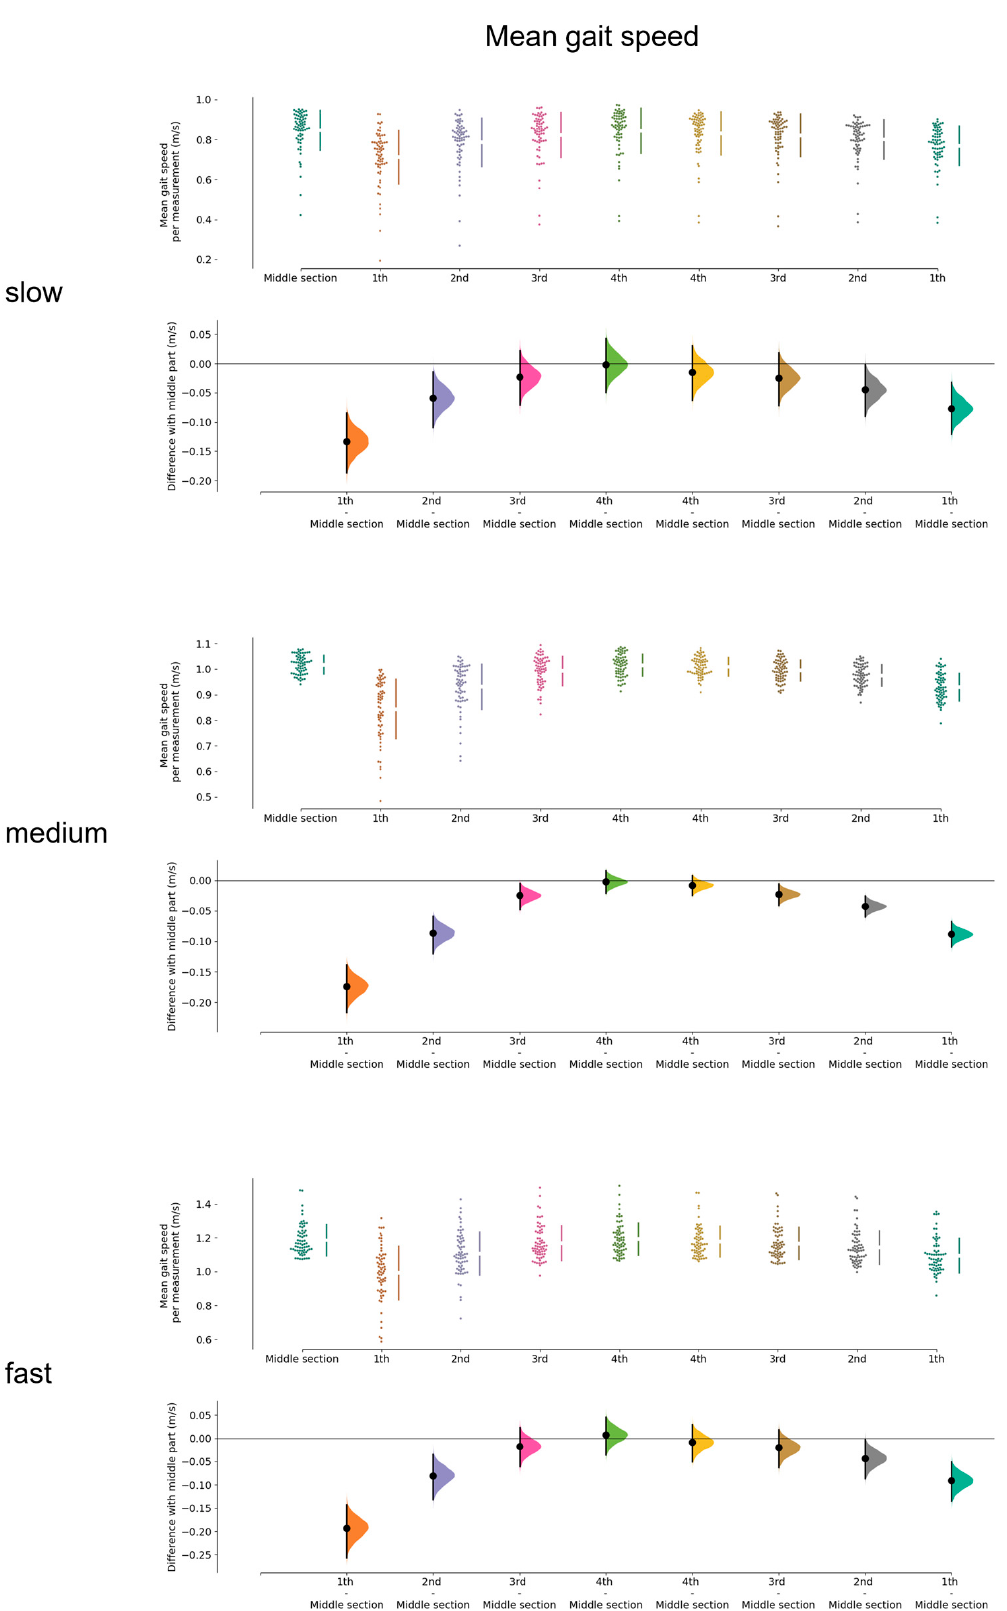
Figure A3. Mean gait speed of the different participants during the walking trajectory, and the mean differences and associated 99% CI of the first and last 4 strides around a turn. The top subplot includes data of the slow gait speed group, the middle subplot of the medium gait speed group and the bottom subplot of the fast gait speed group.